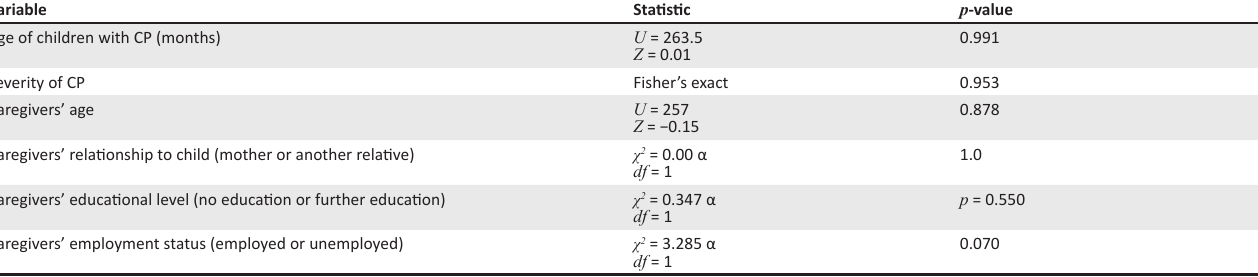
TABLE 4: Relationship between caregivers who were strained and age of children, severity of Cerebral Palsy (CP), caregivers’ age, caregiver relational status, caregivers’ educational and employment status. Variable p -value Age of children with CP